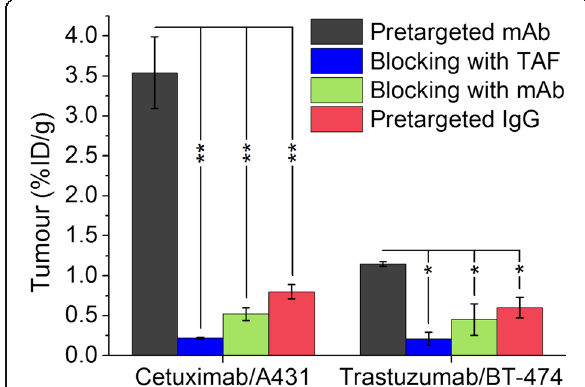
Fig. 6 Tumour uptake values for pretargeted cetuximab and trastuzumab (group A) and nonspecific uptake controls. Nonspecific uptake controls include pretargeted TCO-cetuximab with excess of non-radioactive TAF (blue), pretargeted TCO-cetuximab with excess of mAb (green), and TCO modified immunoglobulin G pretargeted with [ 18 F]TAF (red). The results presented are at 4 h after [ 18 F]TAF injection. The antibody was given 72 h prior to the injection of [ 18 F]TAF. The values represent mean±standard deviation. %ID/g = percentage injected dose/g. * p <0.05 and ** p <0.005 (two-tailed paired t test done with IBM SPSS Statistics